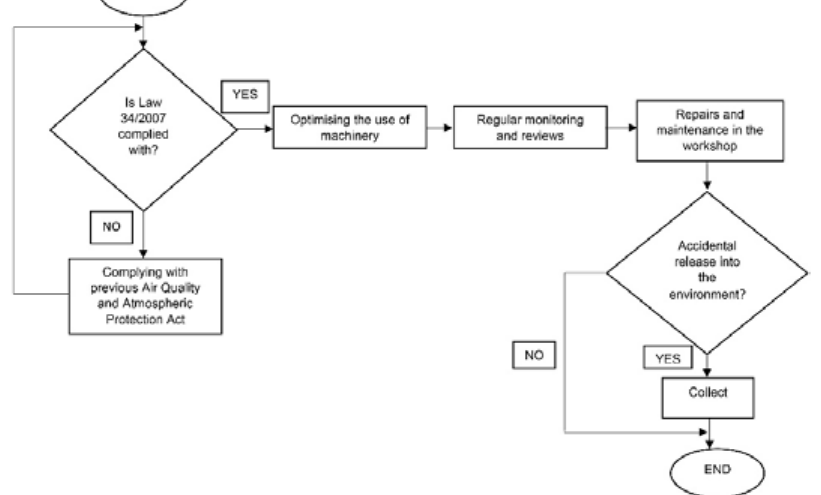
Fig. 4: Flow chart for reducing fuels and lubricants in mining